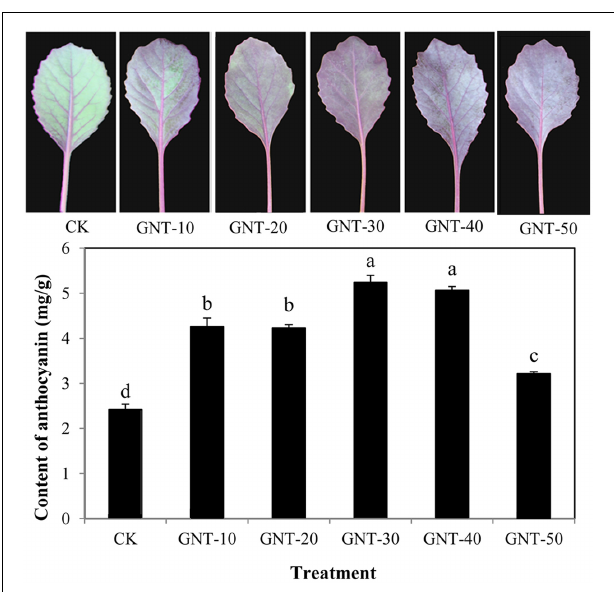
FIGURE 3 | The content of anthocyanin under different concentrations of genistein: GNT-10 (10 mg/L genistein), GNT-20 (20 mg/L genistein), GNT-30 (30 mg/L genistein), GNT-40 (40 mg/L genistein), GNT-50 (50 mg/L genistein). The data are mean ± SD ( n = 3) and the different characters represent significant difference among treatments at P = 0.05 level.